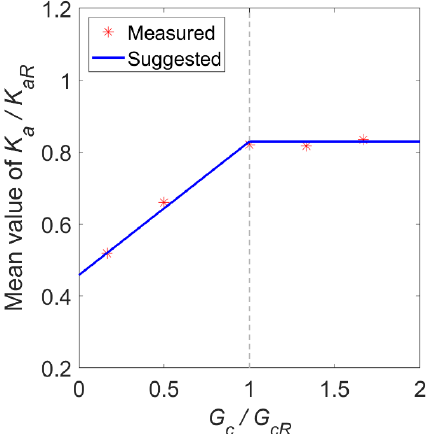
Figure 10. Relative magnitude of the measured coefficient of active earth pressure with respect to Rankine’s coefficient for ( a ) G c < G cR and ( b ) G c ≥ G cR . The dotted lines indicate depth-averaged values of K a / K aR for each condition of G c .